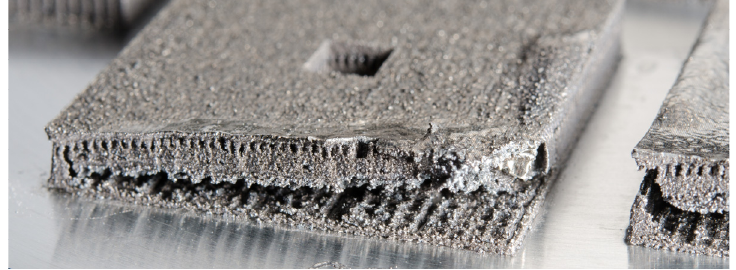
Figure 1. Distortions and delamination during manufacturing process leading to process failure.